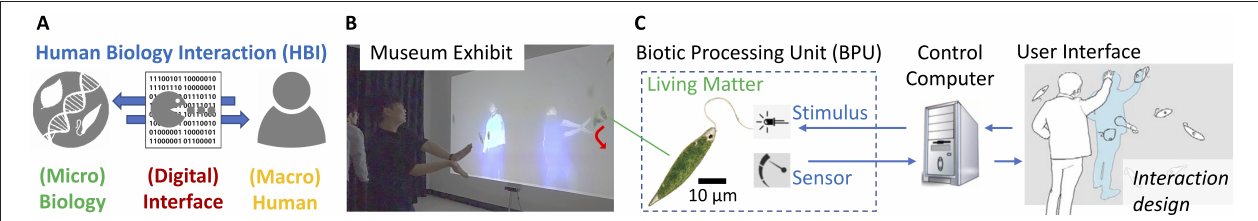
FIGURE 1 | Overview of key concepts of micro-HBI: (A) Interactive Microbiology: Human actions affect microbiological systems such as cells, and their responses are delivered back to humans; these interactions typically require mediation through digital, optical and bioengineering technologies (Riedel-Kruse et al., 2011; Gerber et al., 2016b). (B) Example of an interactive installation that allows a human to interact in real-time with the living microorganism Euglena gracilis by projecting the human body outline as light into the microscope and eliciting a photophobic Euglena response (red arrow), and all of which is then projected onto a larger screen to provide interactive feedback to the human (Lam et al., 2019; Lee et al., 2020). (C) Concept of the biotic processing unit (BPU) (Gerber et al., 2016b) that provides well-defined digital interaction with the microbiological system, i.e., a biological system ( Euglena cell) is housed and can be stimulated and measured. Via a control computer, a user interface enables real-time interaction between human and microbiological systems; interaction design guidelines are therefore important to provide a robust and desired user experience (Gerber et al.,